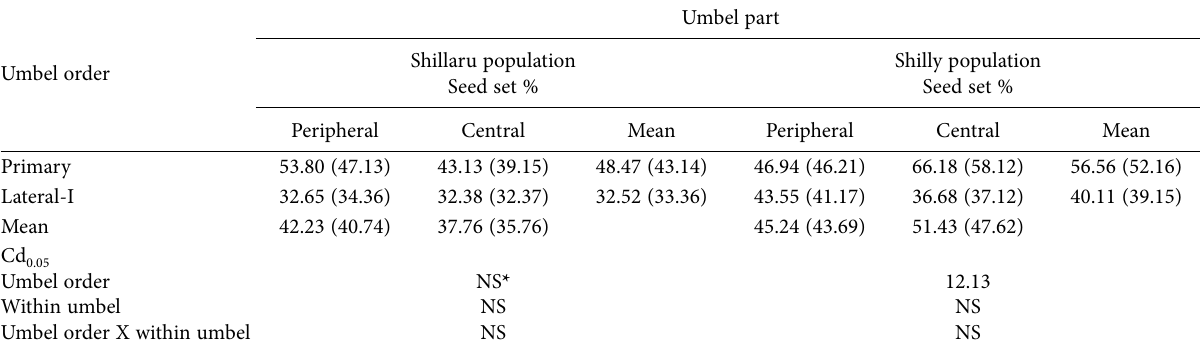
Table 7. Percentage of seeds with embryo among different umbel order vis-à-vis umbel part in population in A. glauca .